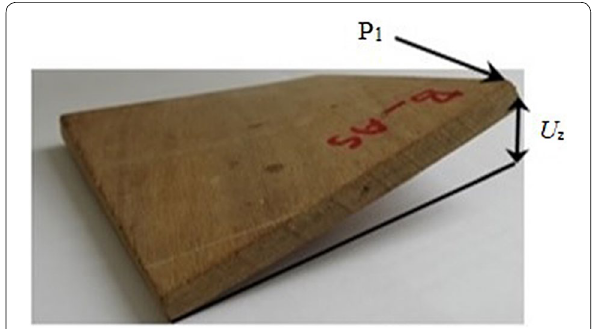
Fig. 9 Displacement of P1 obtained experimentally after 50 h